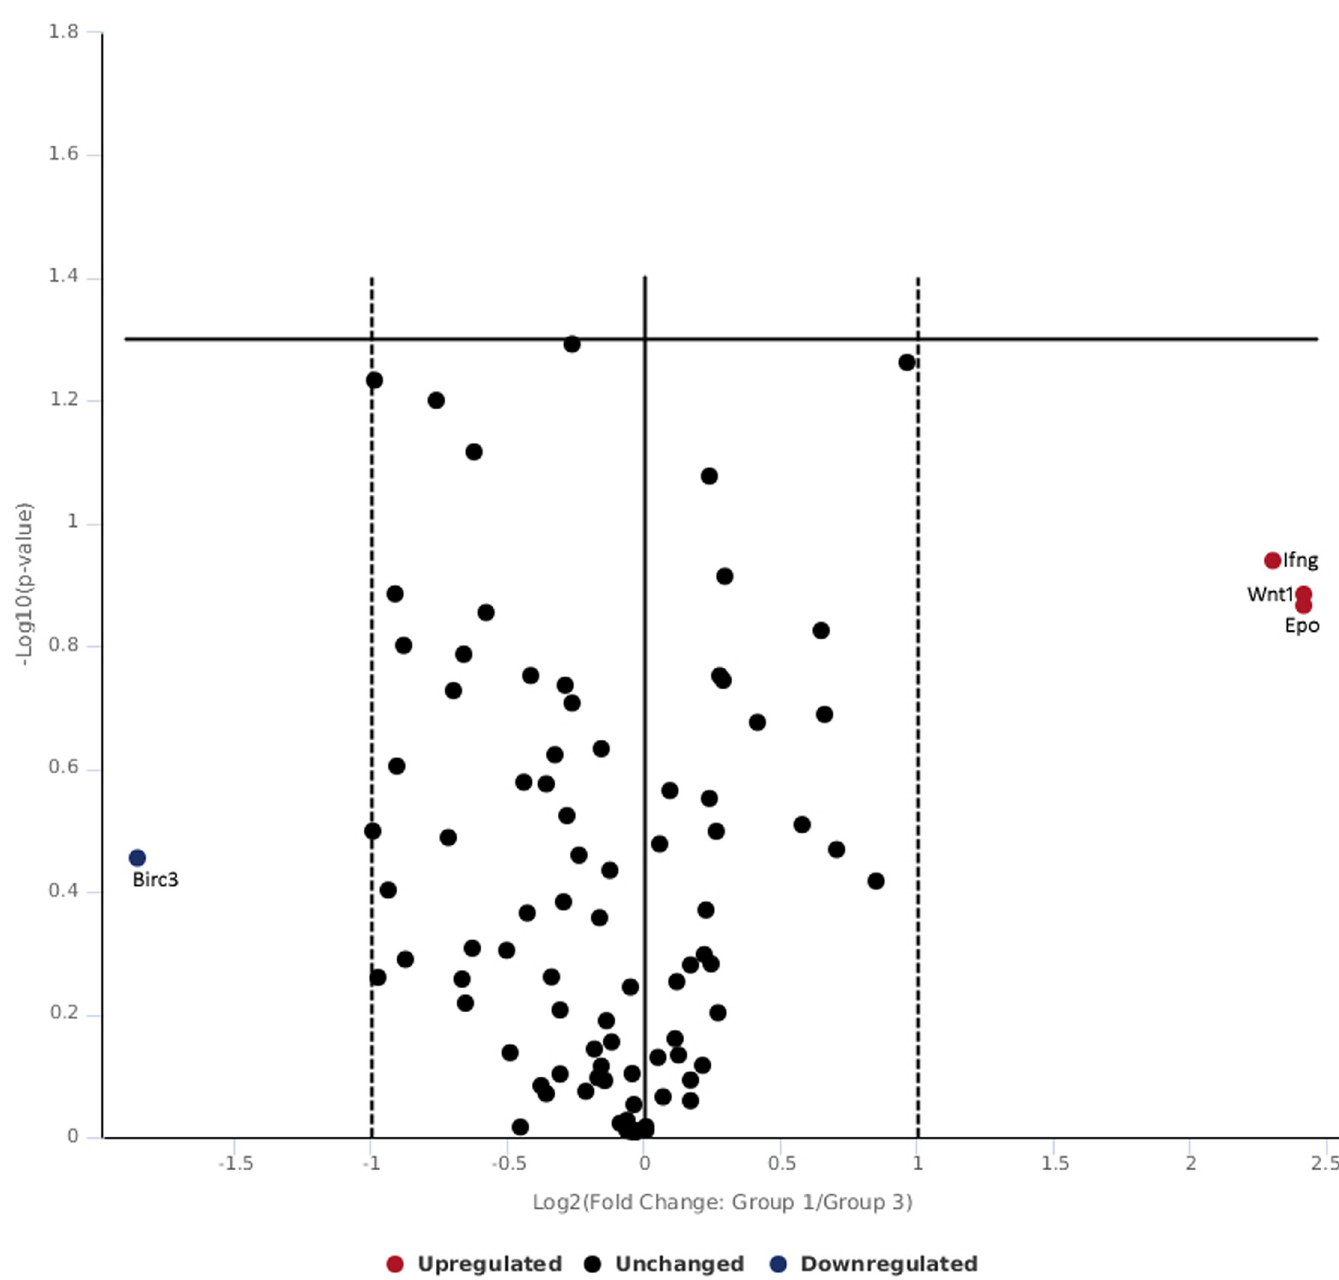
Fig 7. Volcano plot of intergroup comparison of genes expressed following 532 nm laser exposure at low irradiance (0.10 W/cm 2 ) and high irradiance (0.50 W/ cm 2 ).